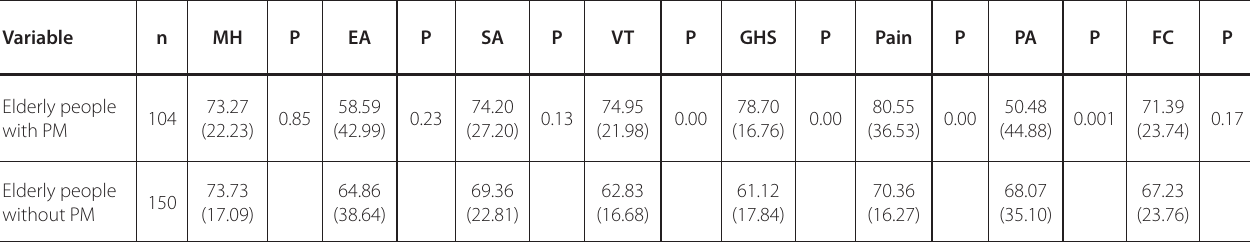
Table 5 . Average scores and standard deviation of SF-36 domains for elderly patients with and without PM. Variable